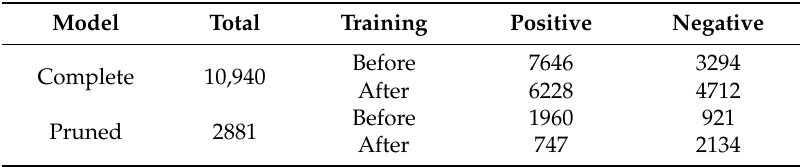
Figure 6. NeuCube weights ( a ) and firing activity ( b ) before training. Subsections ( c ) and ( d ) show changes in the weights and firing activity after training. Table 3. Weights before and after training.